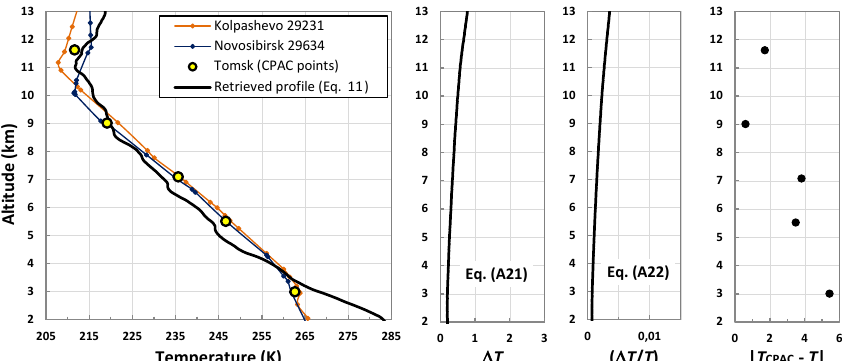
Figure 5. (1 April 2015) Temperature profile retrieved using the temperature retrieval function (Eq. 11) derived from the standard linear calibration function (Eq. 10, Arshinov et al., 1983). The absolute and relative uncertainties (cid:49)T = (cid:49)T and ((cid:49)T/T ) = ((cid:49)T /T ) are calculated by Eqs. (A21) and (A22), respectively. The values T CPAC over Tomsk are retrieved from the 700, 500, 400, 300, and 200hPa constant pressure altitude charts (CPACs). The radiosonde data from the nearest station in Novosibirsk and Kolpashevo are given for comparison.